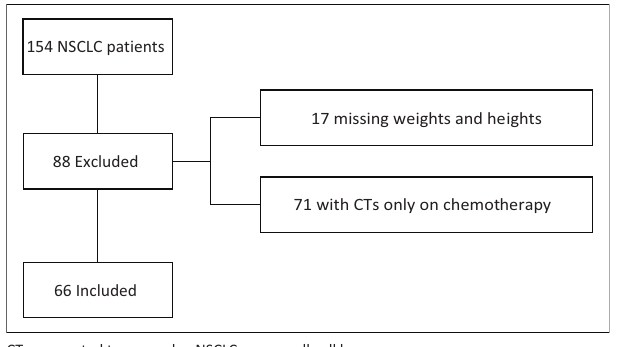
FIGURE 2: Flow diagram demonstrating patient disposition.